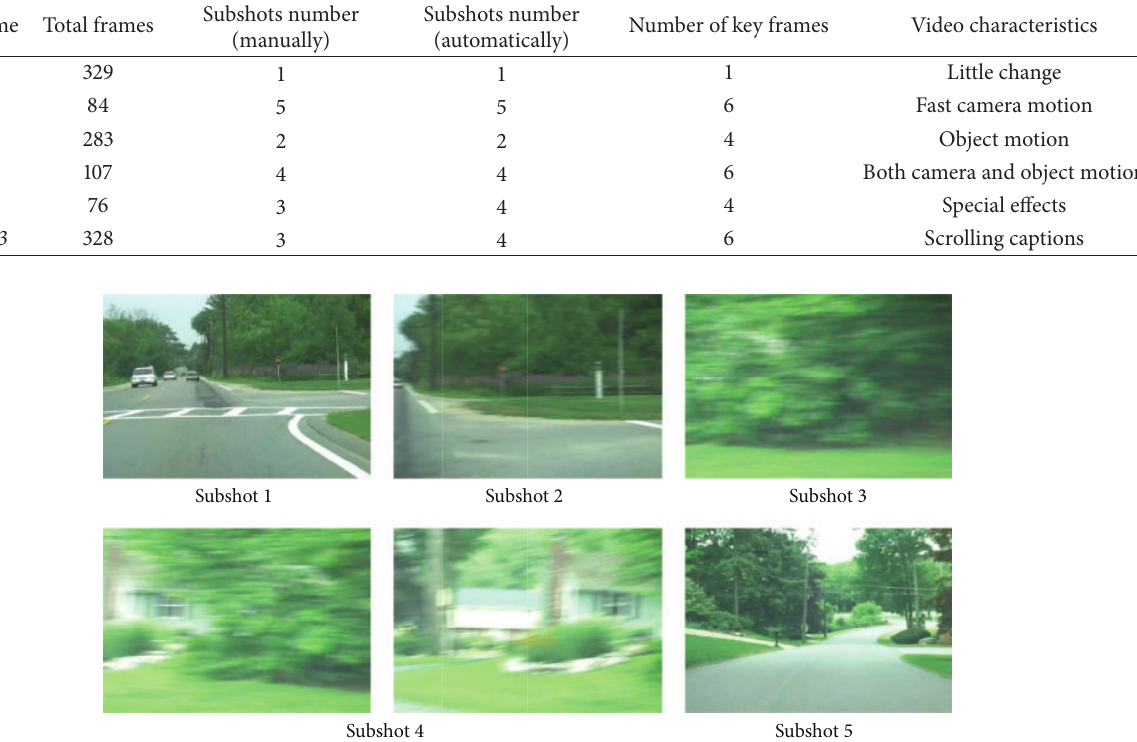
Table 1: Extraction results for different videos.